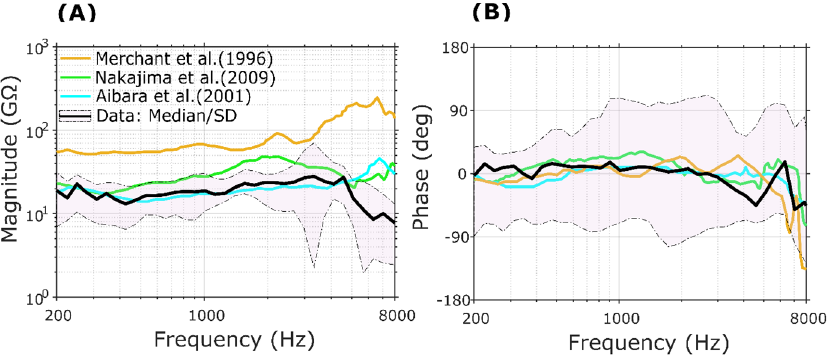
Figure 7. Input cochlea impedance ( Z c ) compared to the reference data: ( A ) magnitude of the Z c and ( B ) respective phase data. The bold black line and the shaded area represent the study data median and the SD, respectively. The literature data are indicated in individual colors.